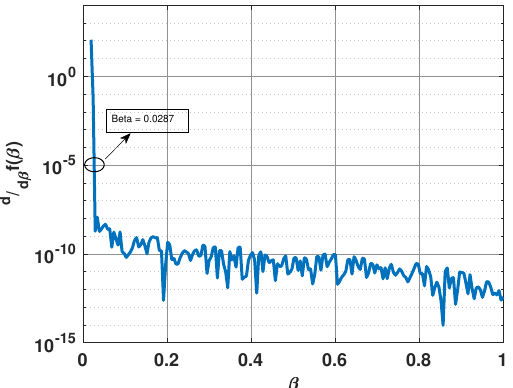
Figure 8. Derivative of f ( β ) versus β for a uniform linear array of 15 elements in the presence of three signals at 57 ◦ , 62 ◦ , and 67 ◦ .